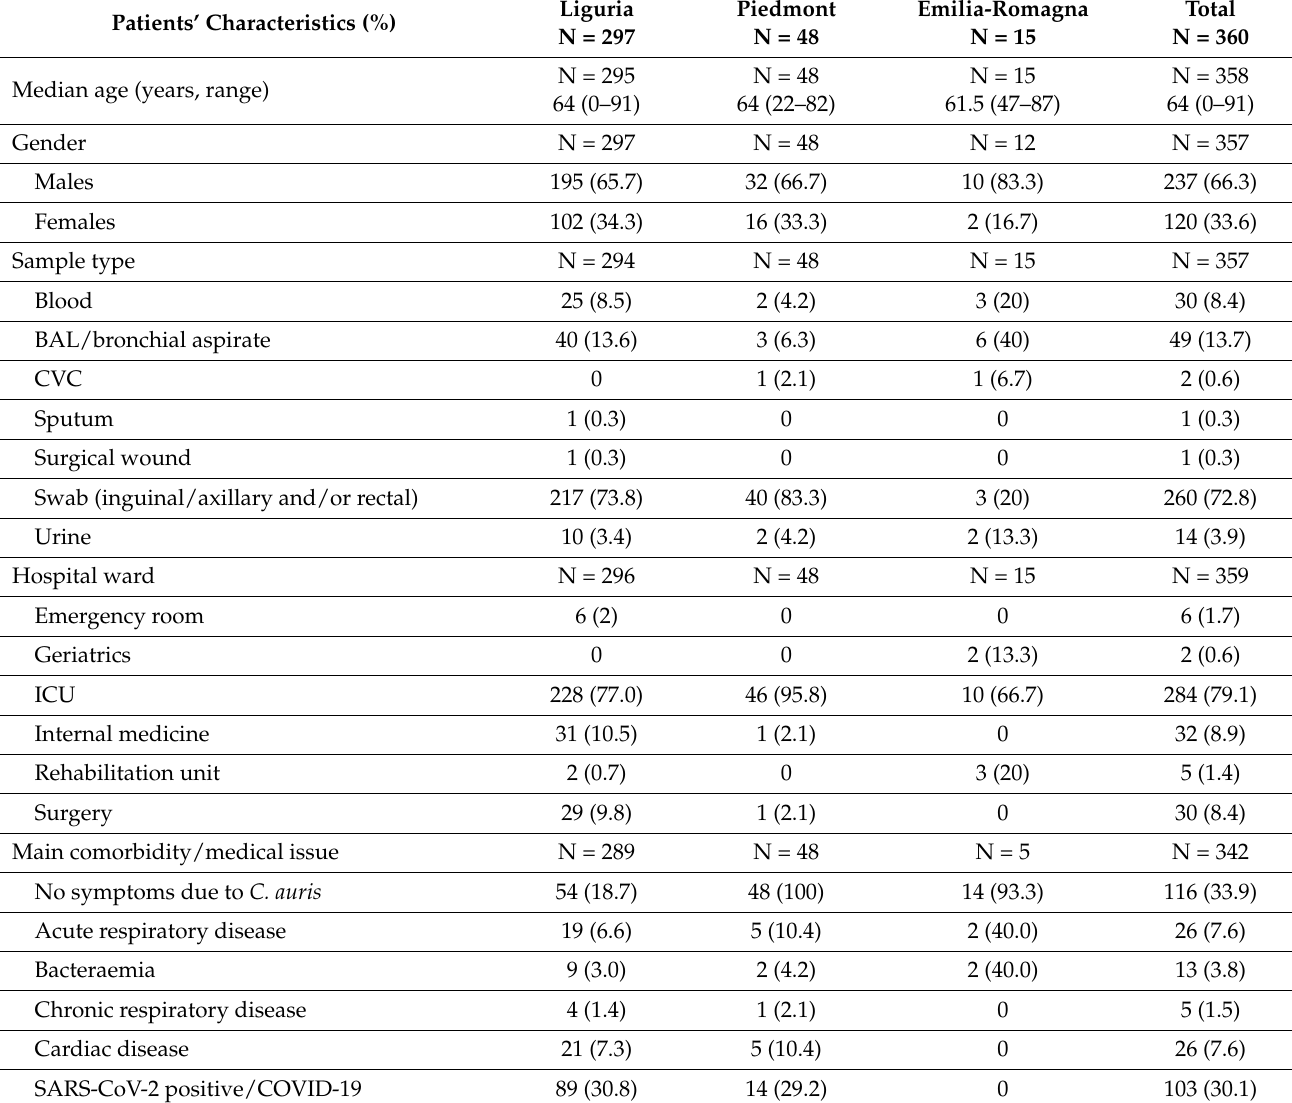
Table 1. Main demographic and clinical characteristics of confirmed C. auris cases, Liguria, Piedmont and Emilia-Romagna regions, Italy, July 2019–December 2022 (N = 360 out of 361 total